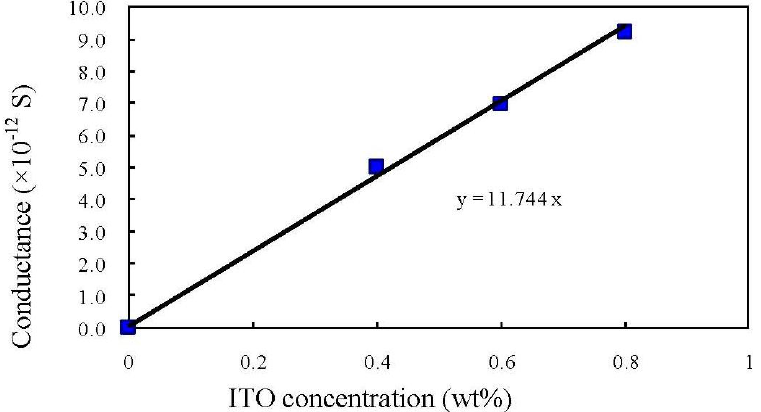
Figure 18. Relation of ITO concentration vs. the inverse of the extracted ITO resistance (1/ R ). ITO